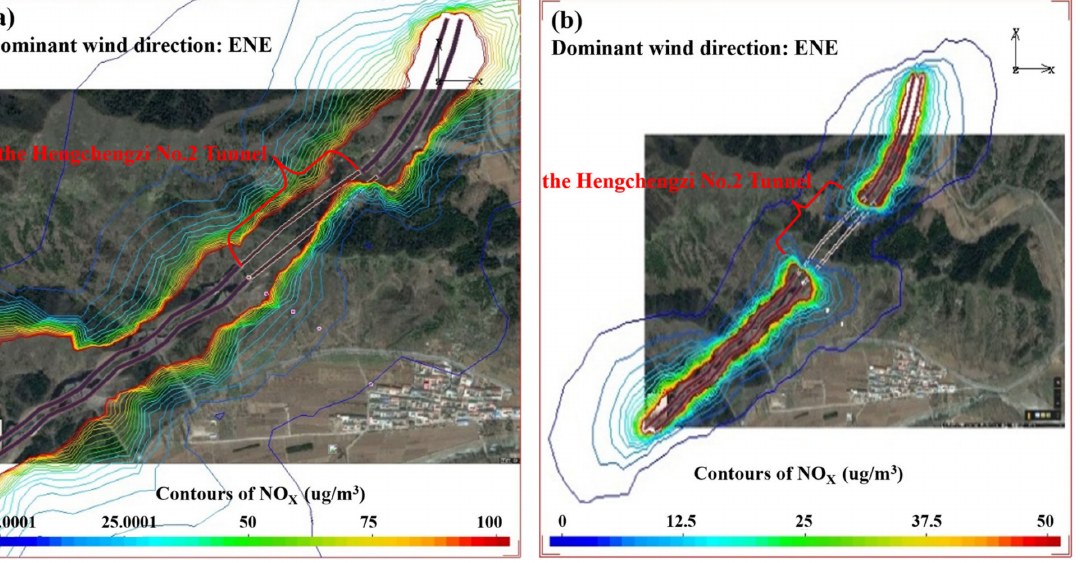
Figure 10. Winter and annual average concentration distribution of NOx in the Hengchengzi No. 2 Tunnel section. ( a ) Average concentration distribution in winter; ( b ) Annual average con- centration